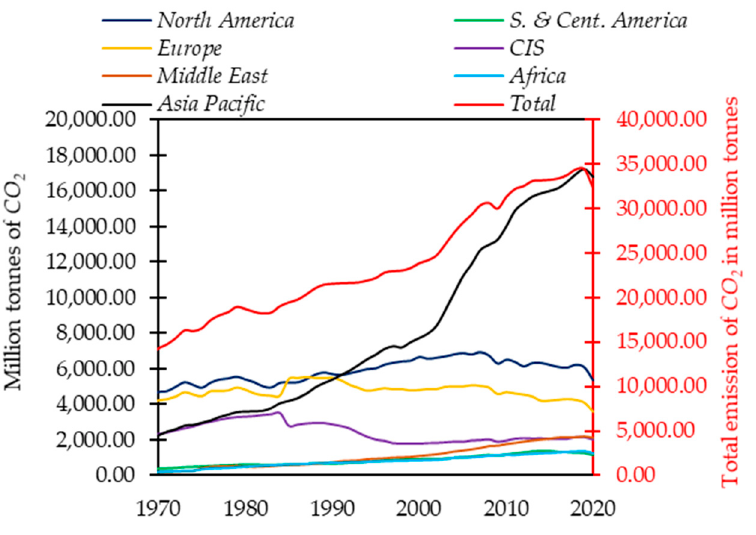
Figure 2. CO 2 emissions in million tonnes based on data reported by BP, 2020.